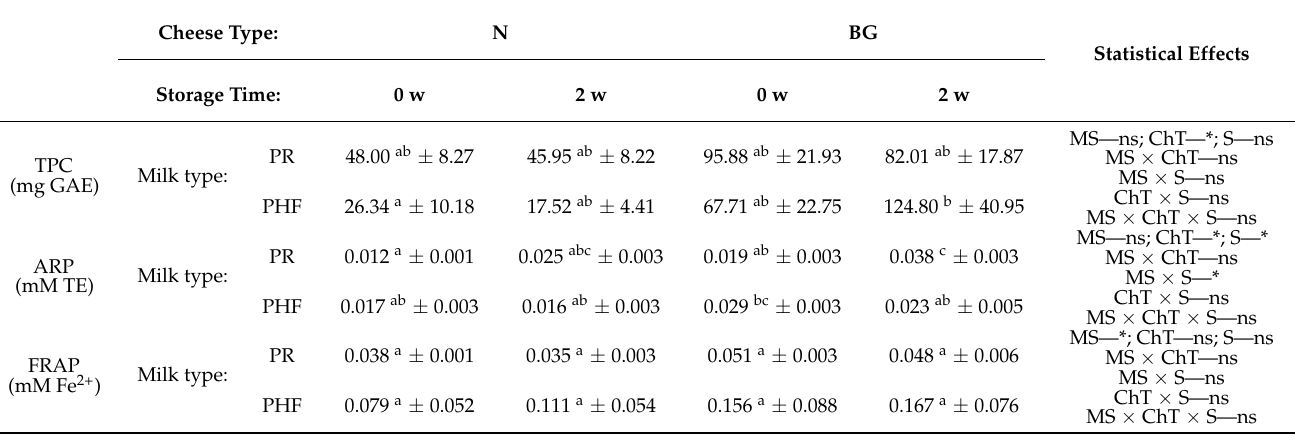
Table 6. Antioxidant activity of the analyzed cheeses (in 100 g of cheese, average ± SE, n = 4).